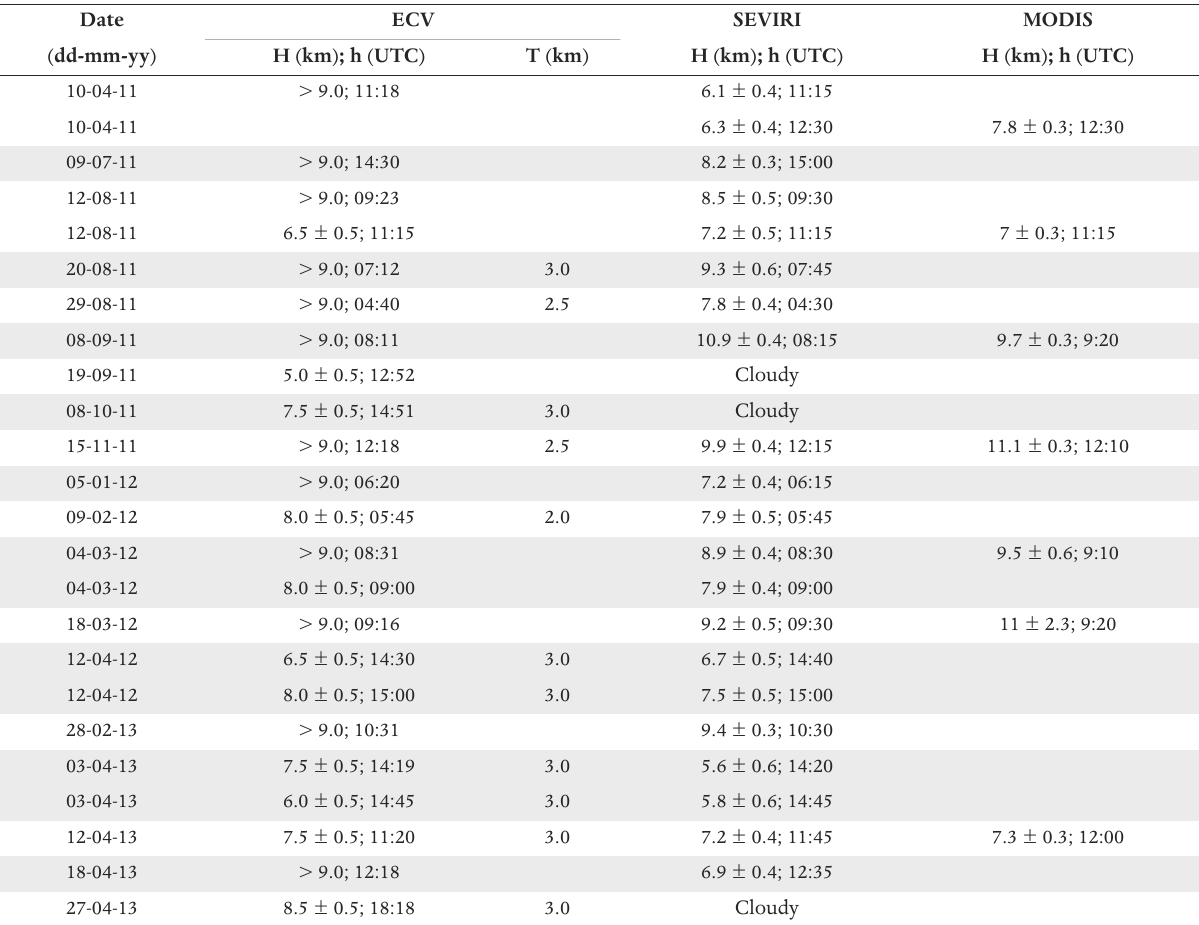
Table 1. Column height (H) a.s.l. estimated from the calibrated video frames (ECV), SEVIRI and MODIS data for lava fountain events. Cloud thickness (T) is indicated when measurable, along with measurement time